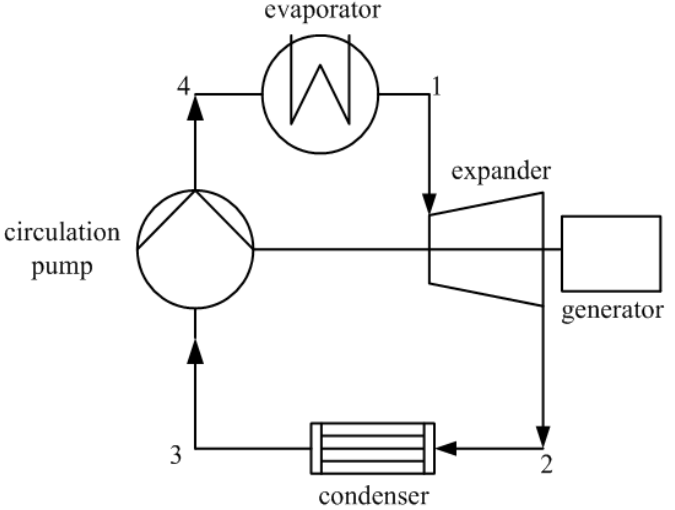
Figure 1. The configuration of an organic Rankine cycle (ORC)